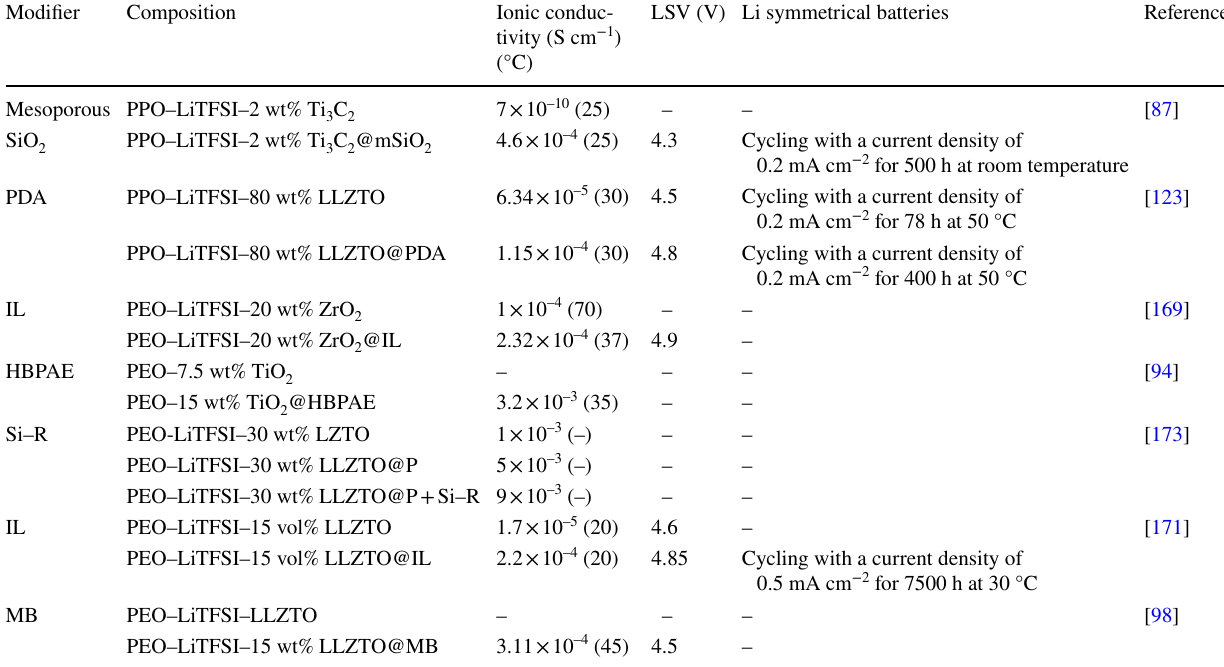
Table 2 Performance comparison of electrolytes with different surface modifiers Modifier